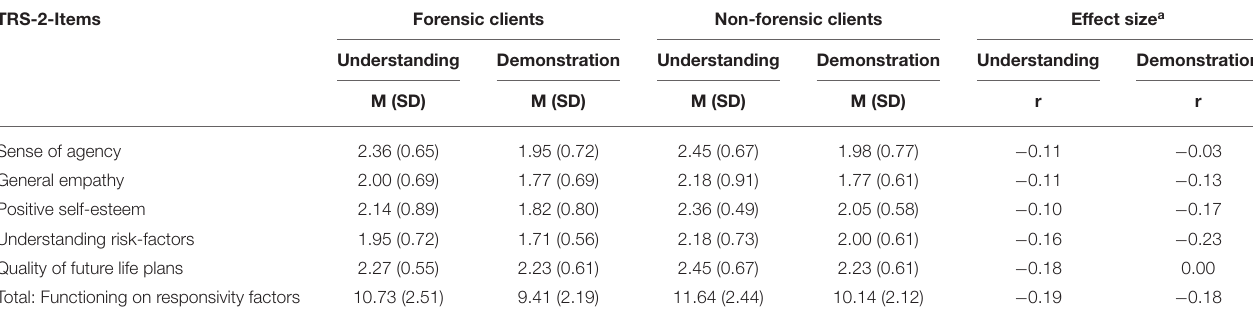
TABLE 3 | Mean scores of forensic ( n TRS-2-Items